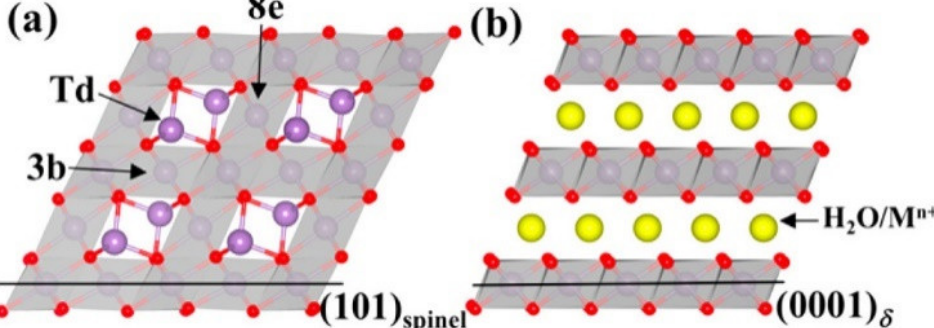
Figure 11. The polyhedral crystal structures representations of ( a ) spinel Mn 3 O 4 (#141, I 41/ AMD ) and ( b ) layered δ-MnO 2 (#166, R 3 ̅ m ). Color code: O, red; H, white, Mn, violet. The yellow sphere represents the presence of H 2 O/M n+ . (Reprinted from ref. [60] with permission from American Chemical Society. Copyright © 2018, American Chemical Society).